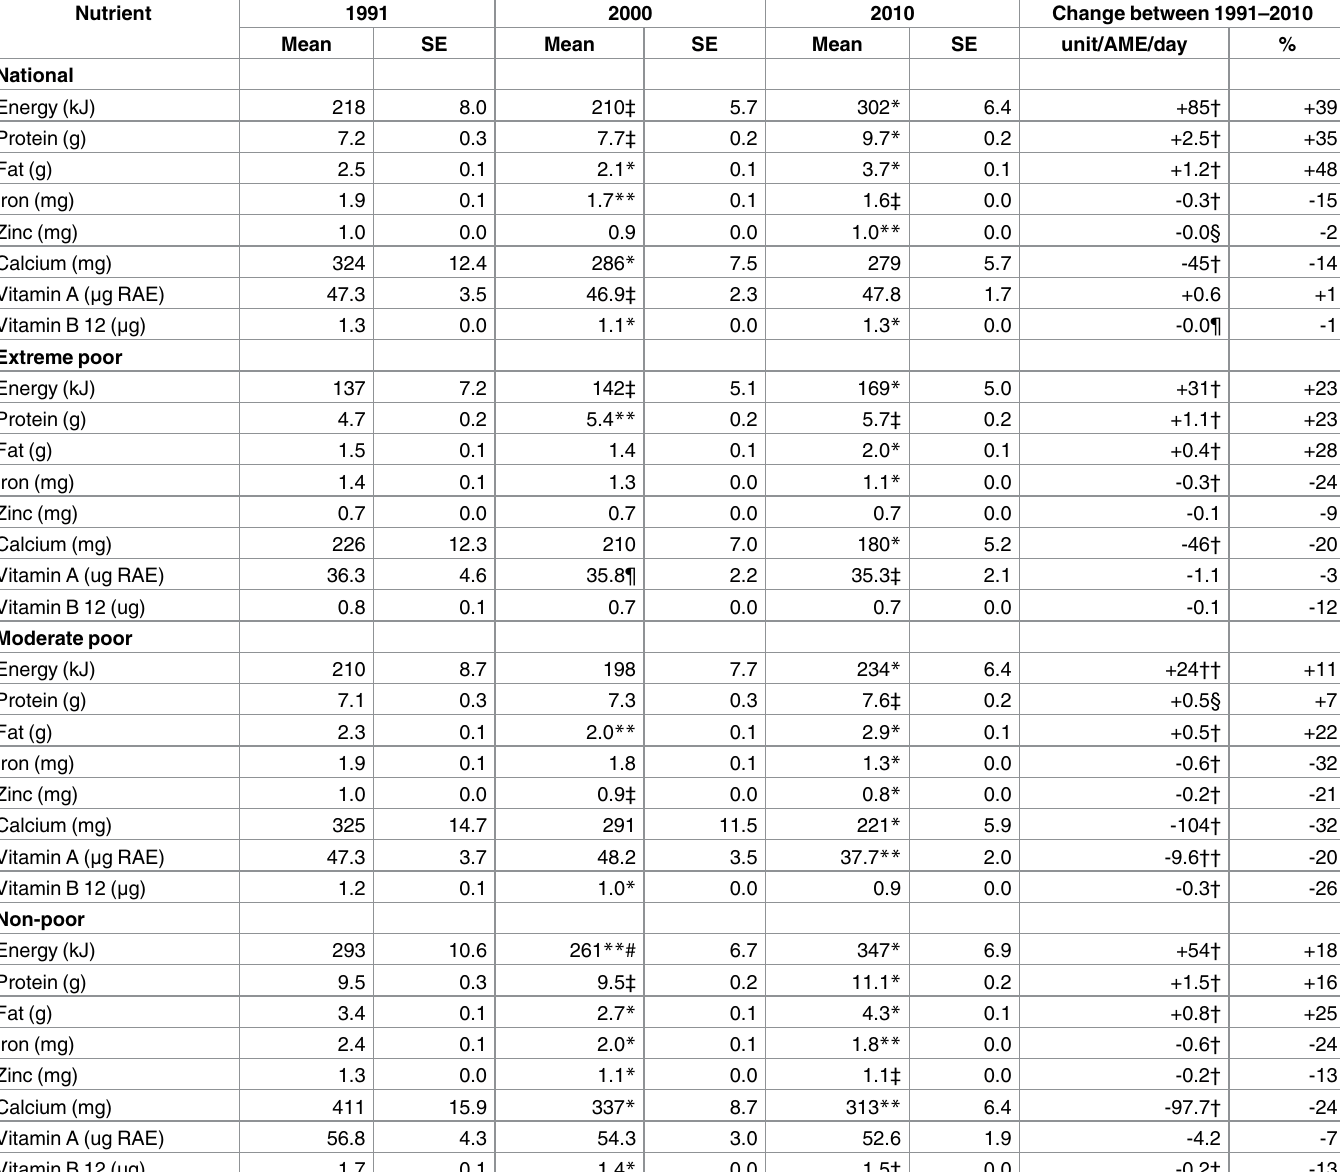
Table 4. Mean nutrient intakes (nutrient/AME/day) from fish, nationally and by poverty groups over time.